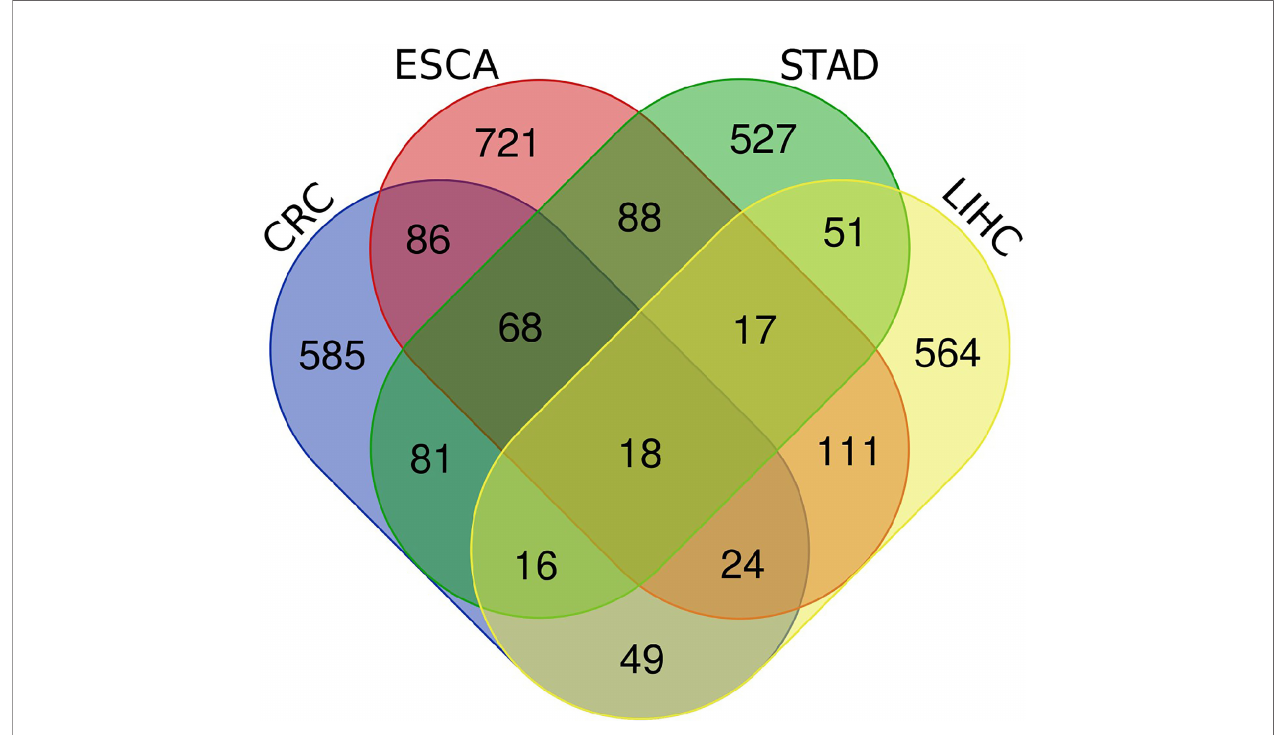
FIGURE 1 | The venn diagrams of four digestive system cancers. A total of 18 HRlncRNAs were obtained from CRC, ESCA, STAD and